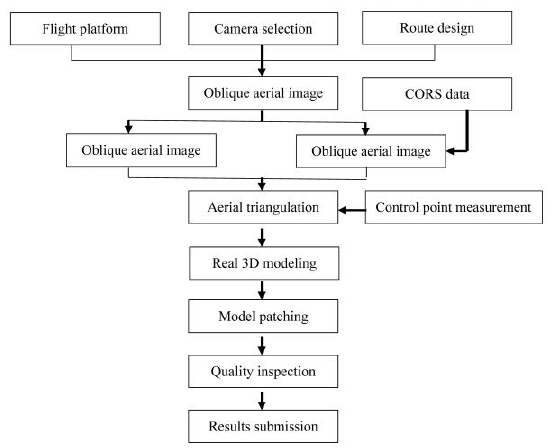
Figure 1 ． Workflow of the oblique photogrametry real 3D model